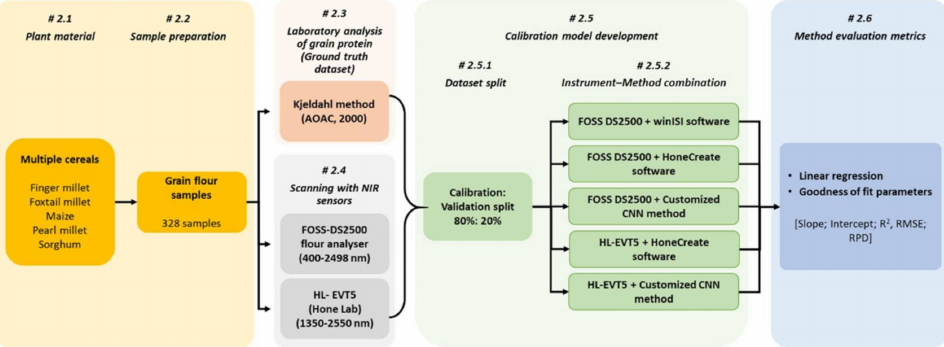
Figure 1. Graphical overview of the methodology visualizing the process used for testing the NIR instruments and methods for prediction of protein content in multiple cereal